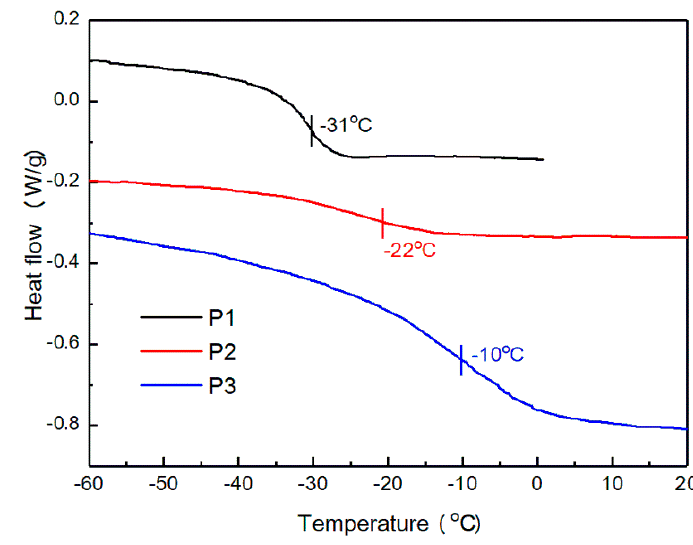
Figure 7. The DSC curves indicating glass transition of the three films.